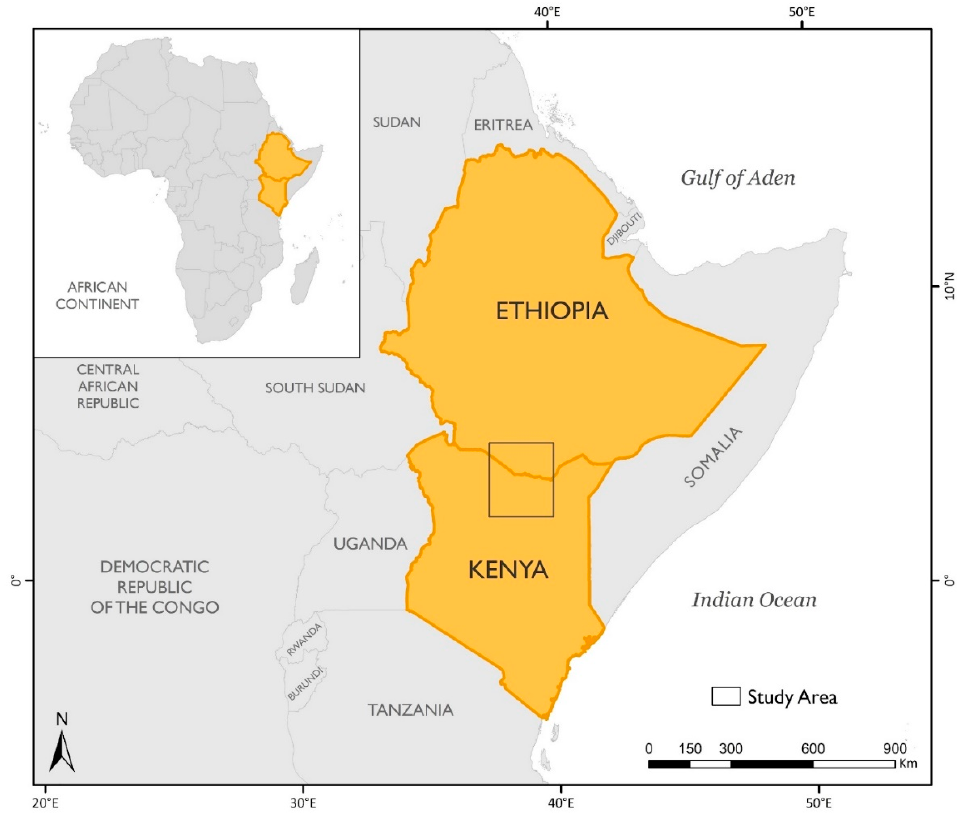
Figure 1. Location of the study area in Southern Ethiopia (Borana) and Northern Kenya (Marsa-